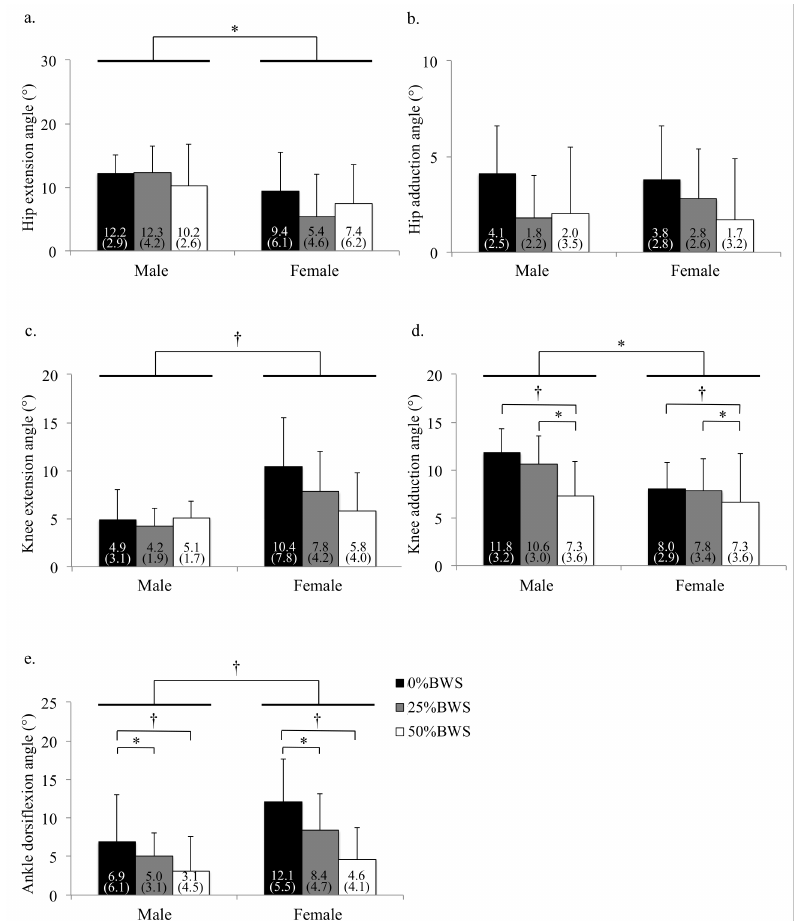
Figure 7. The peak angle of each joint during stance phase under 0%, 25% and 50%BWS conditions for male and female participants (( a ) hip extension, ( b ) hip adduction, ( c ) knee extension, ( d ) knee adduction, ( e ) ankle dorsiflexion). Data are reported as mean (standard deviation). * p < 0.05, † p < 0.01, BW: body